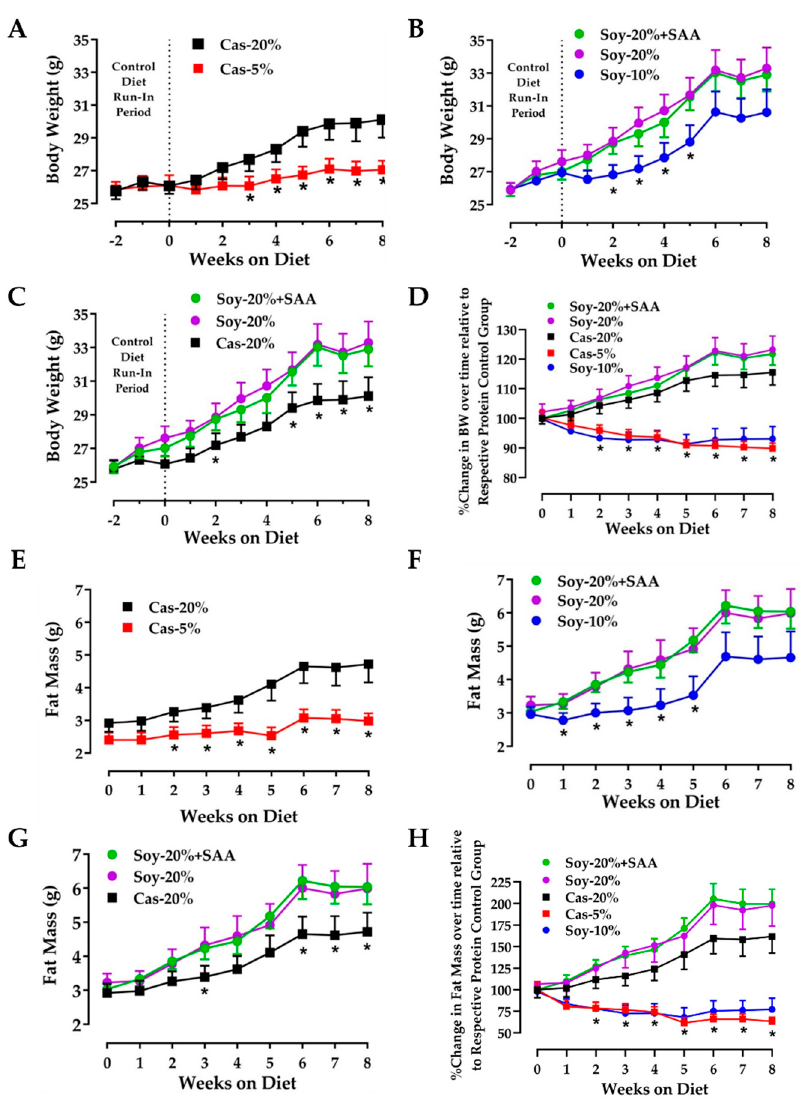
Figure 1. Impact of protein restriction on body weight ( A – D ) and fat mass ( E – H ) in mice fed control or protein-restricted diets for 8 weeks beginning at 12 weeks of age. Cas-20% served as the control group for casein protein restriction and Soy-20% and Soy-20% + SAA served as control groups for soy protein restriction. Dietary composition of the respective diets is described in Materials and Methods. Body weight and composition were measured weekly for the entire study. In Figure 1D,H, the changes in body weight (Figure 1D) and fat mass (Figure 1H) were expressed as percent change in the respective variable relative to the body weight and fat mass at zero time. The change in body weight and fat mass over time were analyzed using a repeated measures one-way ANOVA as described in the Materials and Methods, and means from protein-restricted groups annotated with an ‘asterisk” differ from their respective control groups at p < 0.05. Data in each figure panel are presented as the mean ± SEM, n = 9–10.